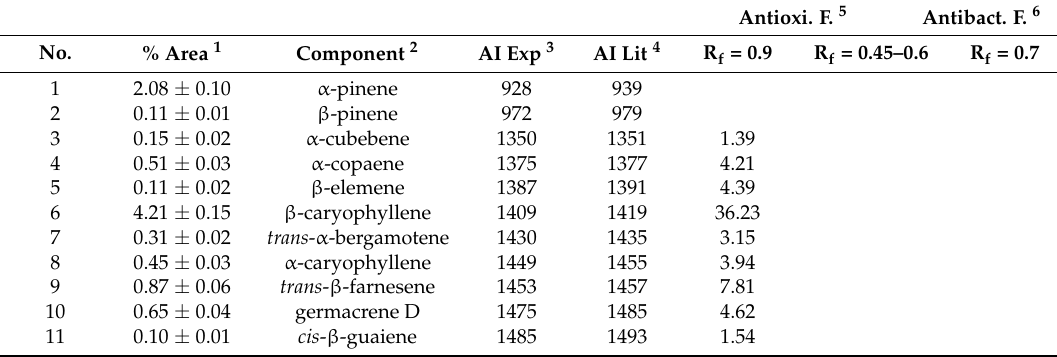
Table 1. Chemical composition of M. splendens essential oil and its characterization in term of active antioxidant and antibacterial compounds isolated respectively from DPPH-HPTLC (1,1-diphenyl-2- picrylhydrazil-high performance thin layer chromatography) and HPTLC bioautography assays. Antioxi. F. 5 Antibact. F.